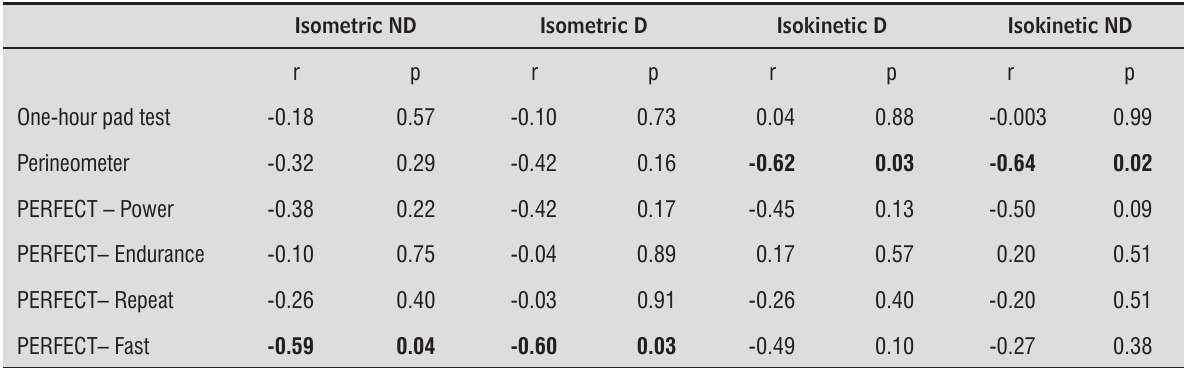
Table 3 - Correlation between final evaluation isometric and isokinetic hip adductors peak torque and one hour pad